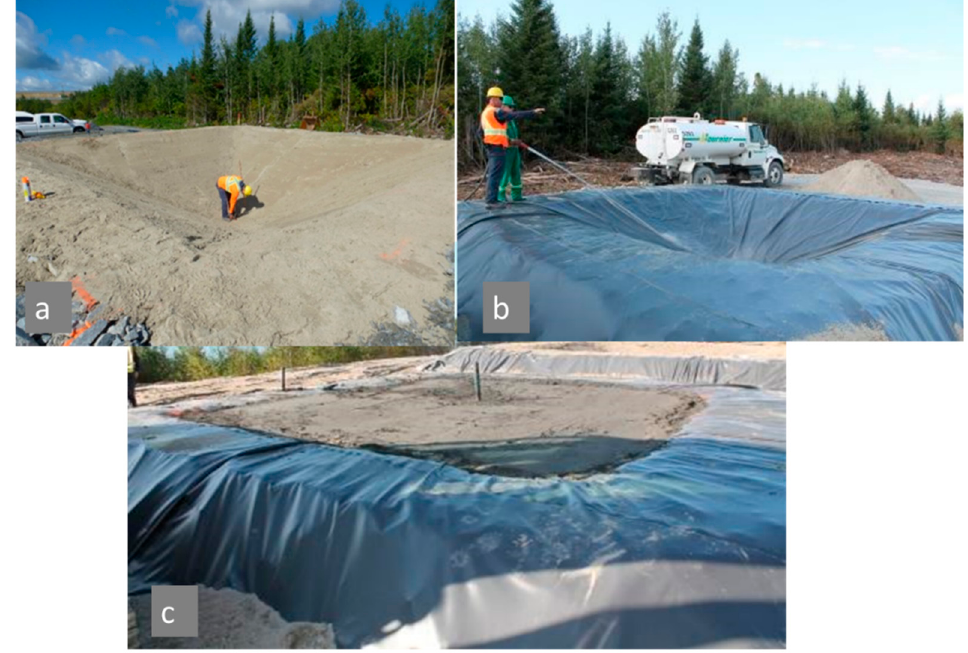
Figure 3. ( a , b ) sand and geomembrane installation, respectively, and ( c ) filling the control cell with reactive tailings.